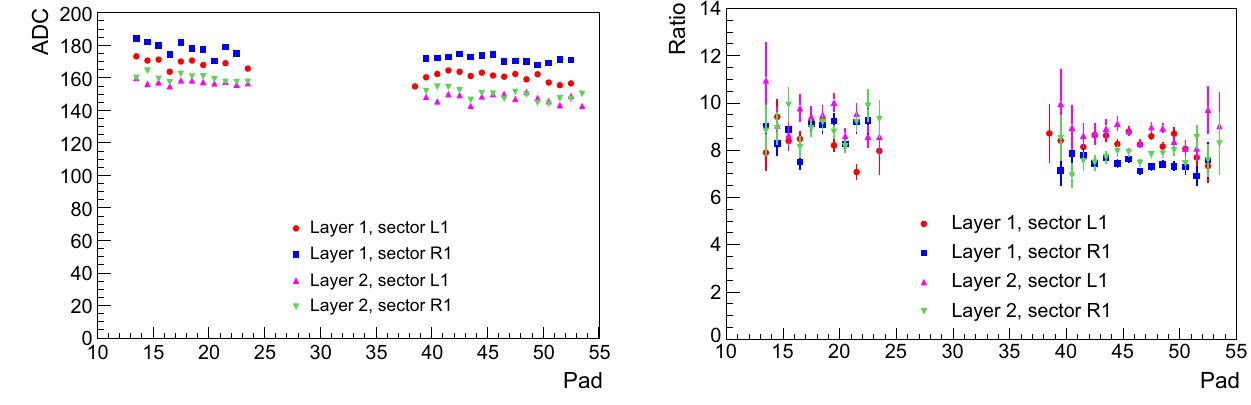
Fig. 10 Most probable value of the signal in the pads of the tracking layers covered by the electron beam of 5 GeV